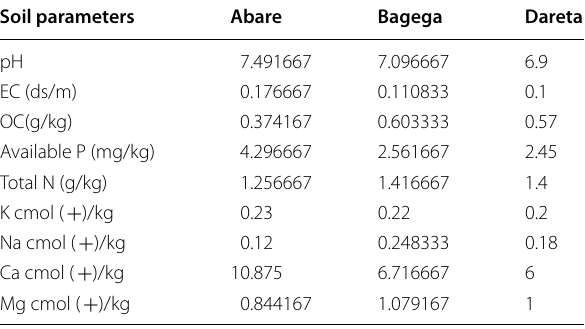
OC: organic carbon; EC: electric conductivitiy, pH, soil acodity